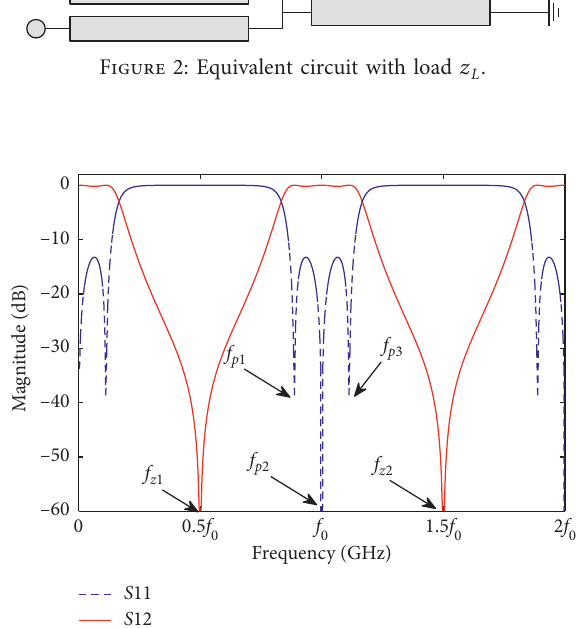
Figure 3: The calculated frequency responses for Figure